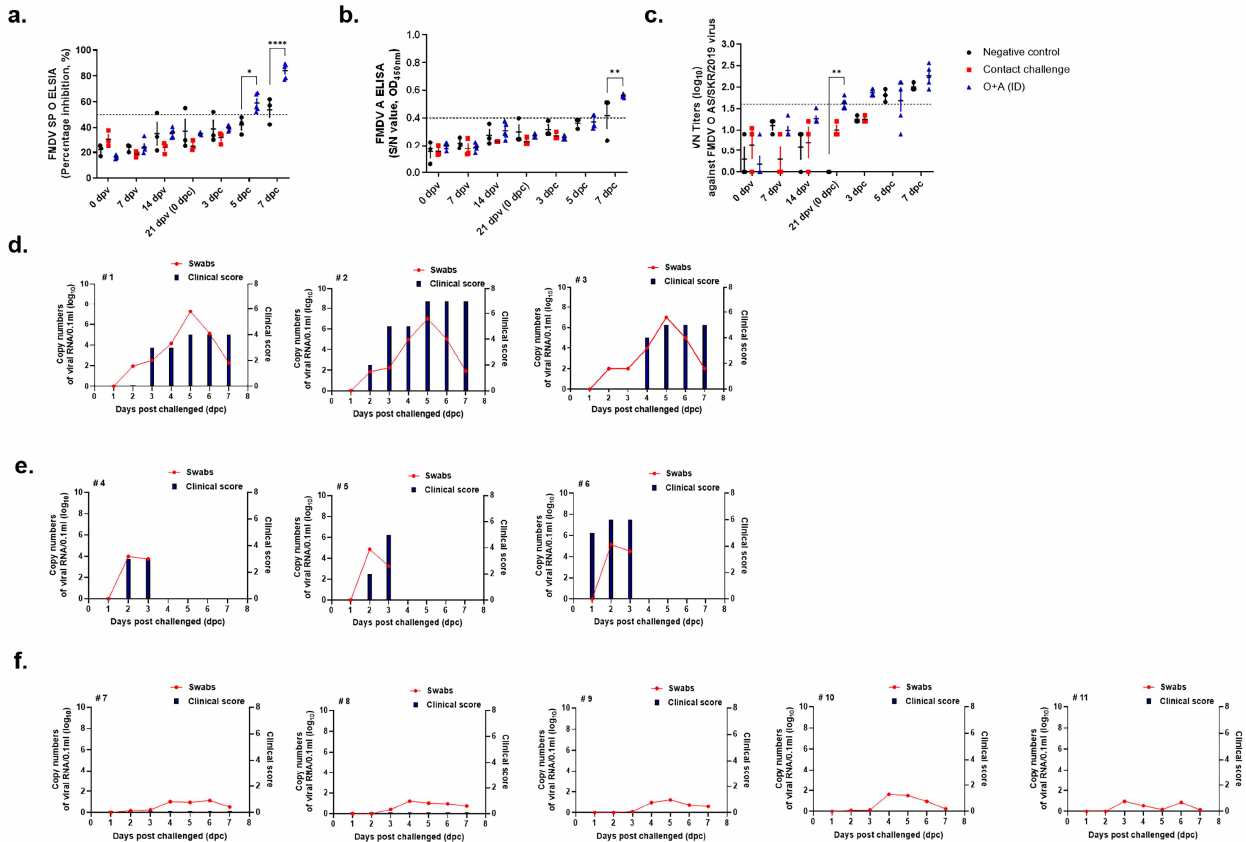
Figure 4. Clinical scores and FMDV RNA levels in swine immunized and VN titer after contact infection with donor swine inoculated with the O/AS/SKR/2019 strain. After vaccination, the swine were challenged with the O/AS/SKR/2019 strain. FMDV RNA levels in nasal swabs were measured by qRT-PCR from 0 to 7 days after challenge. Serum samples from the swine at 0, 7, 14, and 21 dpv, and 0, 3, 5, and 7 dpc were analyzed via VN assay. ( a ) Percentage inhibition (PI) value of FMDV type O SP ELISA in individuals. ( b ) Percentage inhibition (PI) value of FMDV type A SP ELISA in individuals. ( c ) VN titers against O/AS/SKR/2019 strain. ( d ) The clinical scores and FMDV RNA levels in negative group. ( e ) The clinical scores and FMDV RNA levels in contact infection group. ( f ) The clinical scores and FMD virus RNA levels in ID vaccination group. ID: intradermal injection; the datasheets are the mean ± SEM; statistical analyses were performed using two-way ANOVA; *, p < 0.05; **, p < 0.01; ***, p < 0.001; and ****, p <